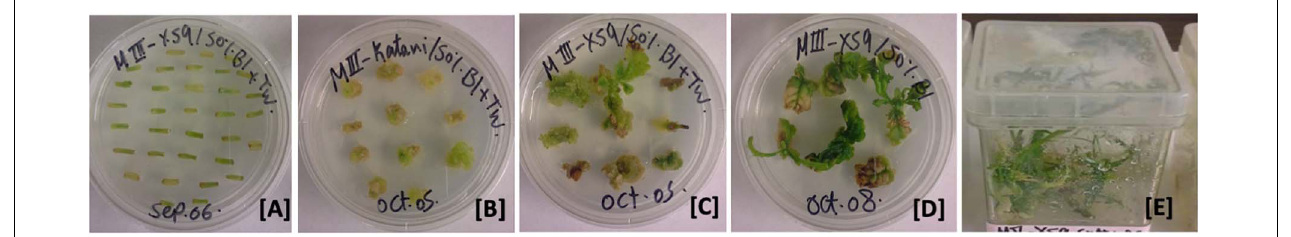
FIGURE 3 | Hemp tissue culture propagation. (A) Hypocotyl explants on callus-induction media. (B) Hypocotyl explants with the callus on callus induction media. (C,D) Callus and developing shoots on shoot-induction media. (E) Developed shoots on root-induction media.